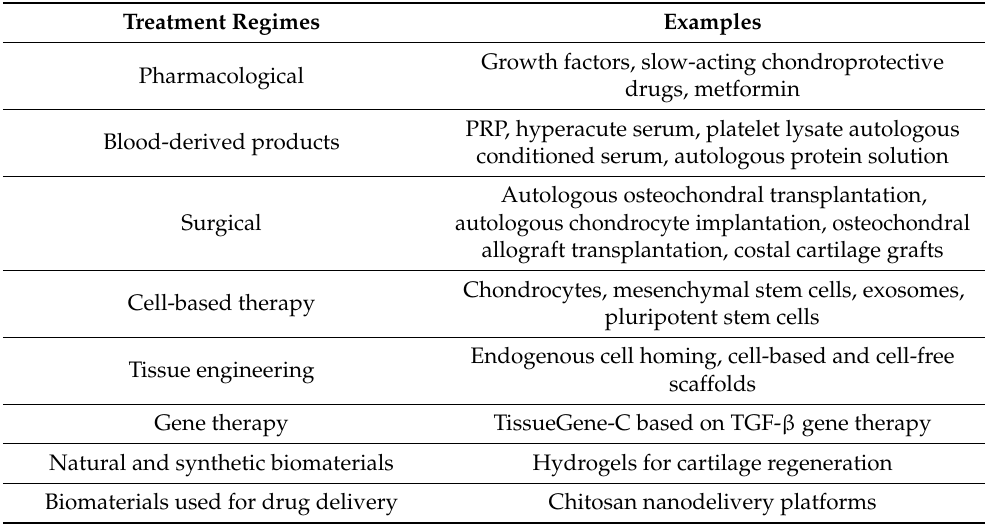
Table 2. Treatment of